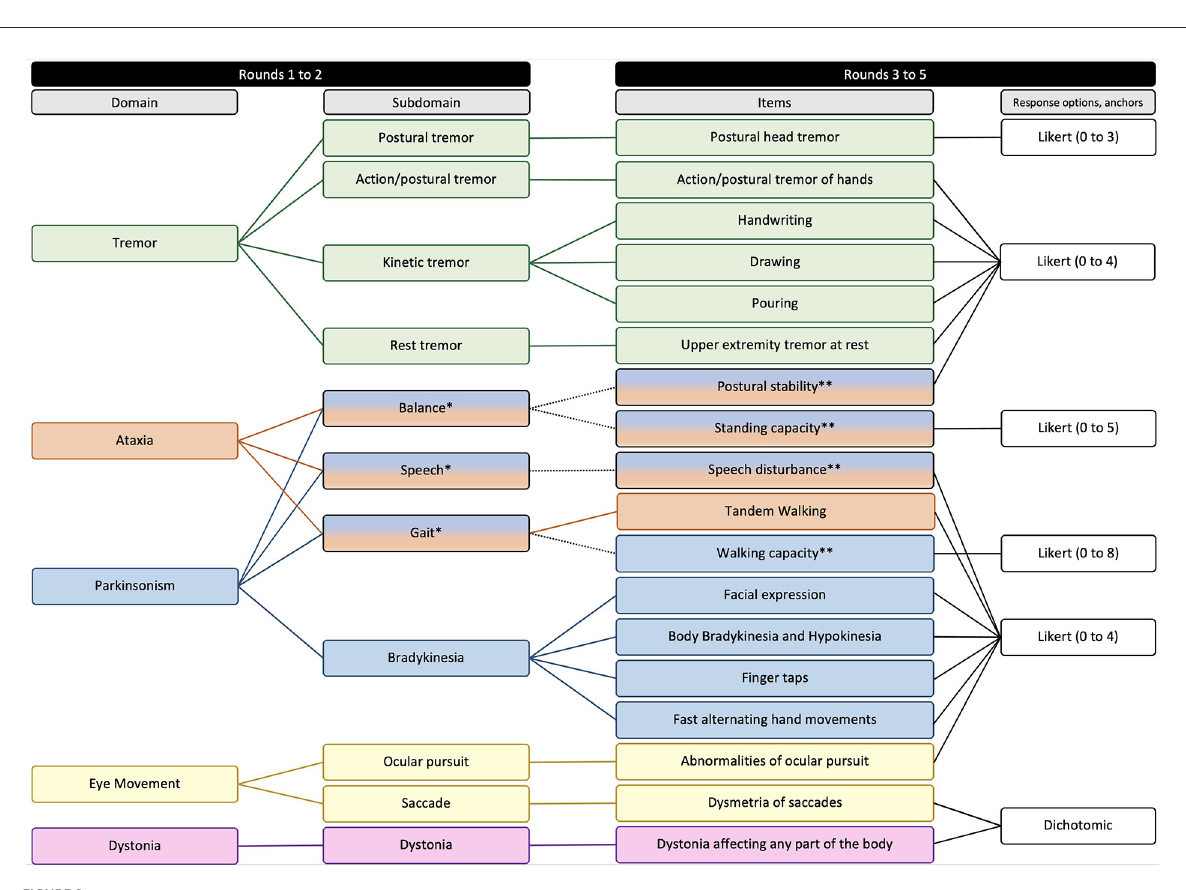
FIGURE2 Domains, subdomains, items, and response options composing the second version of FXTAS-RS. *Subdomains represented by more than one domain. **Items represented by more than one